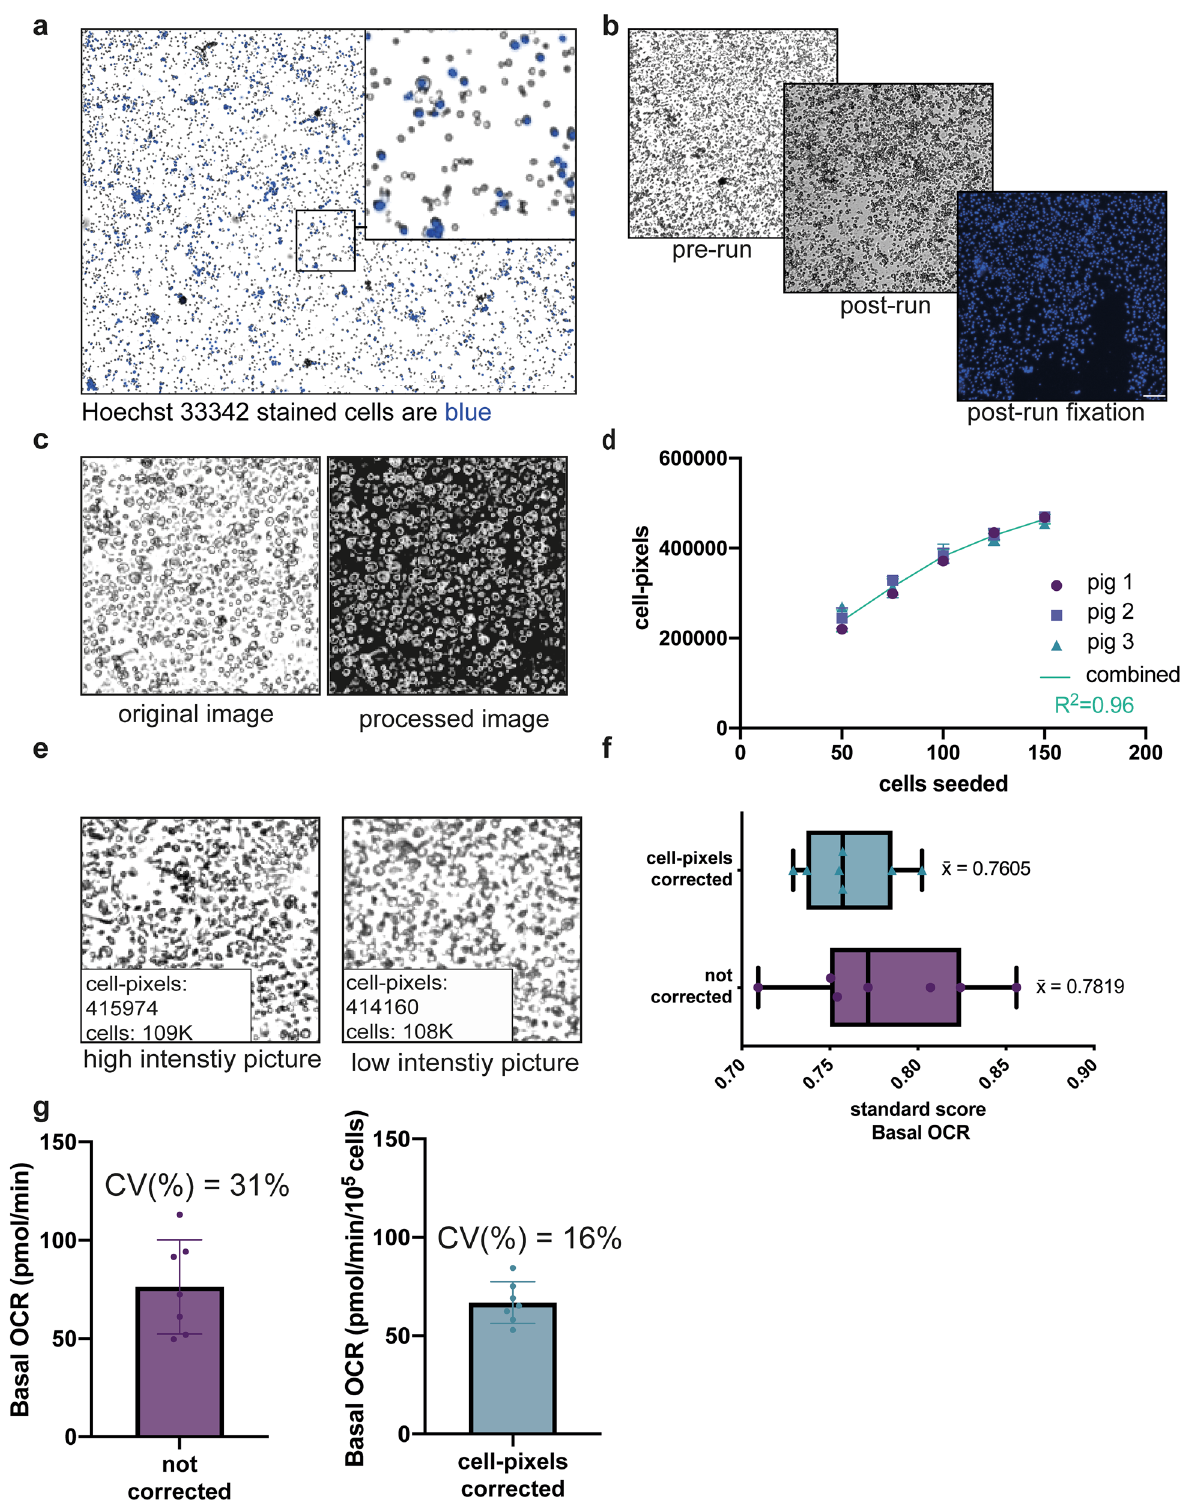
Figure 2. Optimization of normalization for metabolic Seahorse measurements. ( a ) Hoechst 33342 staining of isolated IECs. ( b ) Images depicting the same well pre-run, post-run and post-fixation and DAPI staining. ( c ) Pre-run brightfield images are processed for image analysis, yielding a white-object-on-black-background image. ( d ) Correlation of cell-pixels to the number of cells expected to be seeded for three pigs and their combined correlation coefficient (50,000–150,000 cells/well, n = 4 wells per cell concentration). The combined calibration curve for the three pigs was used to convert cell-pixel values back into cell numbers. ( e ) Images with varying image intensities show similar cell-pixel values, with corresponding also similar cell number values. ( f ) Within-pig variation, as represented by standard score, of basal OCR measurement in a group of piglets corrected using our cell-pixel image analysis (n = 7 pigs). ( g ) Coefficient of variation (%), as a measure of between-pig variation, of basal OCR measurement in the same group of piglets (n = 7). Representative images are